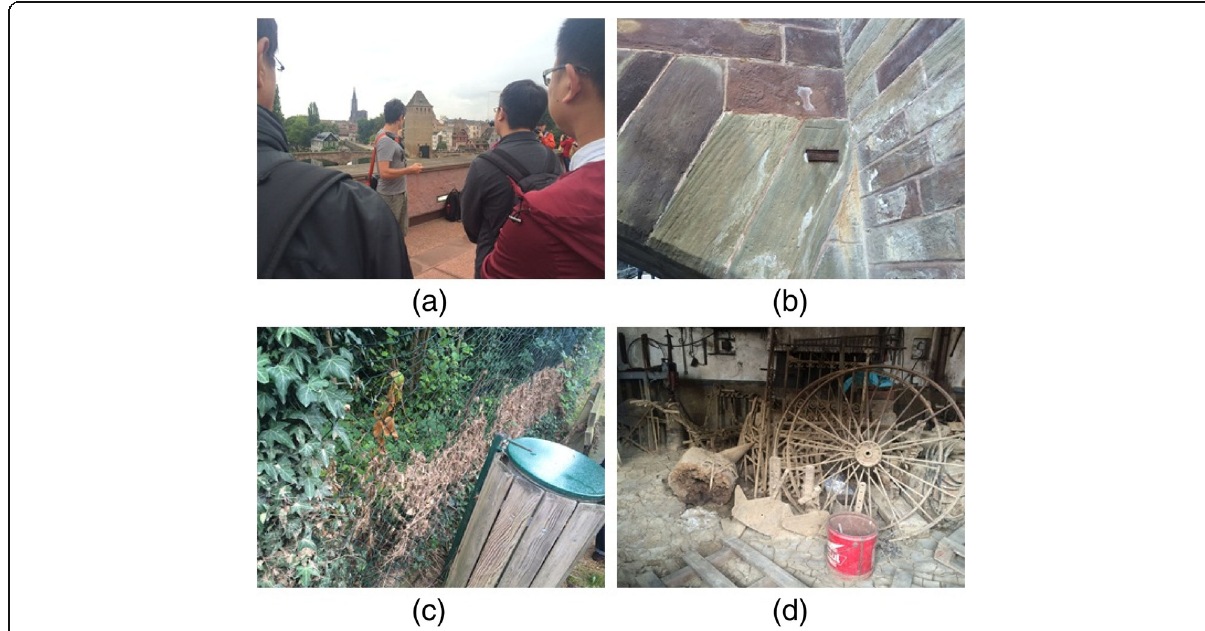
Fig. 5 Photos at the field excursion. a Introduction to the flooding prevention measures in Strasburg; b The historical flooding level at the bridge; c The trace left by flooding on the fence in the village near Strasburg in May; d The house after being flooded by water